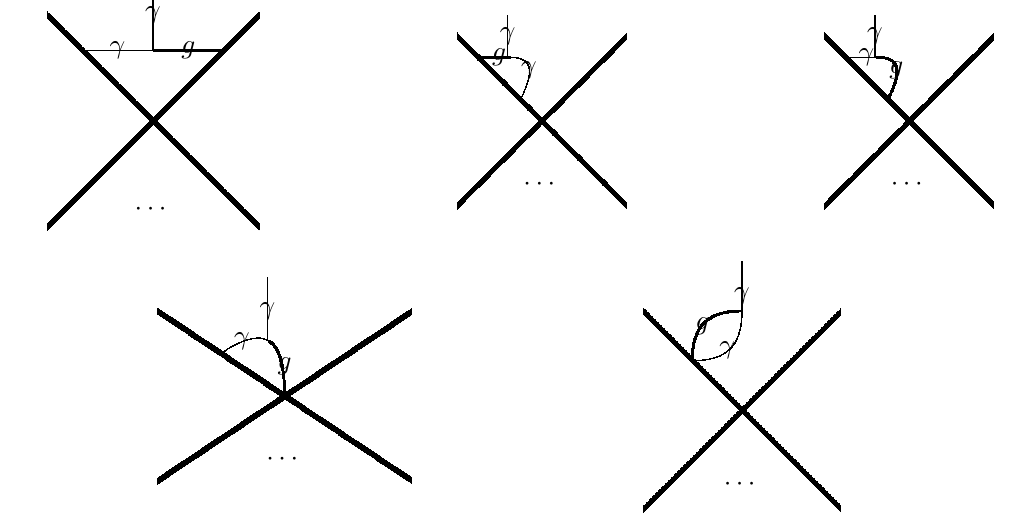
Figure 24 . Diagrams involving graviton-photon-photon vertex that need to be included in com- puting the soft graviton contribution to the soft photon